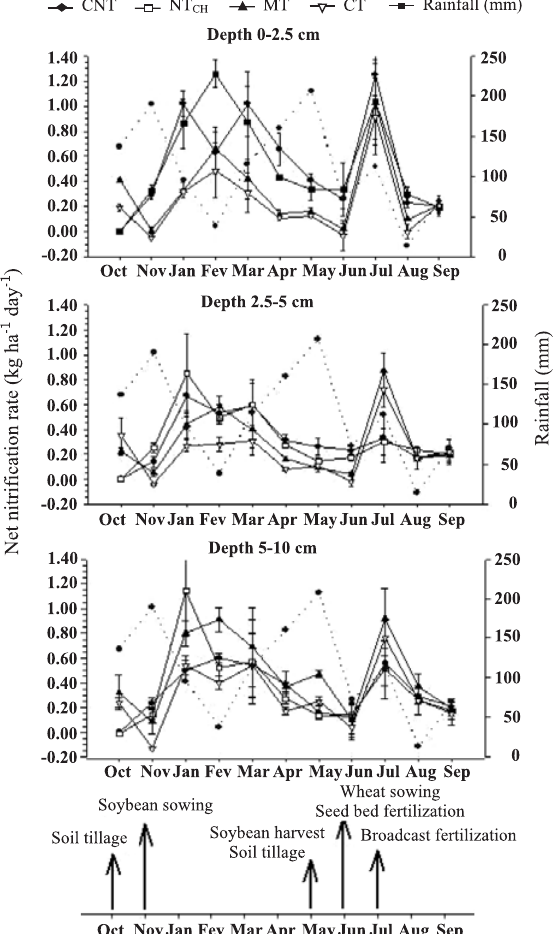
Figure 3. Net nitrification rates in the 0–2.5, 2.5–5 and 5–10 cm layers under continuous no-tillage (CNT), no-tillage with chisel plow (NT minimum tillage (MT) and conventional tillage (CT) from October 2003 to August 2004. The results represent the average ± the